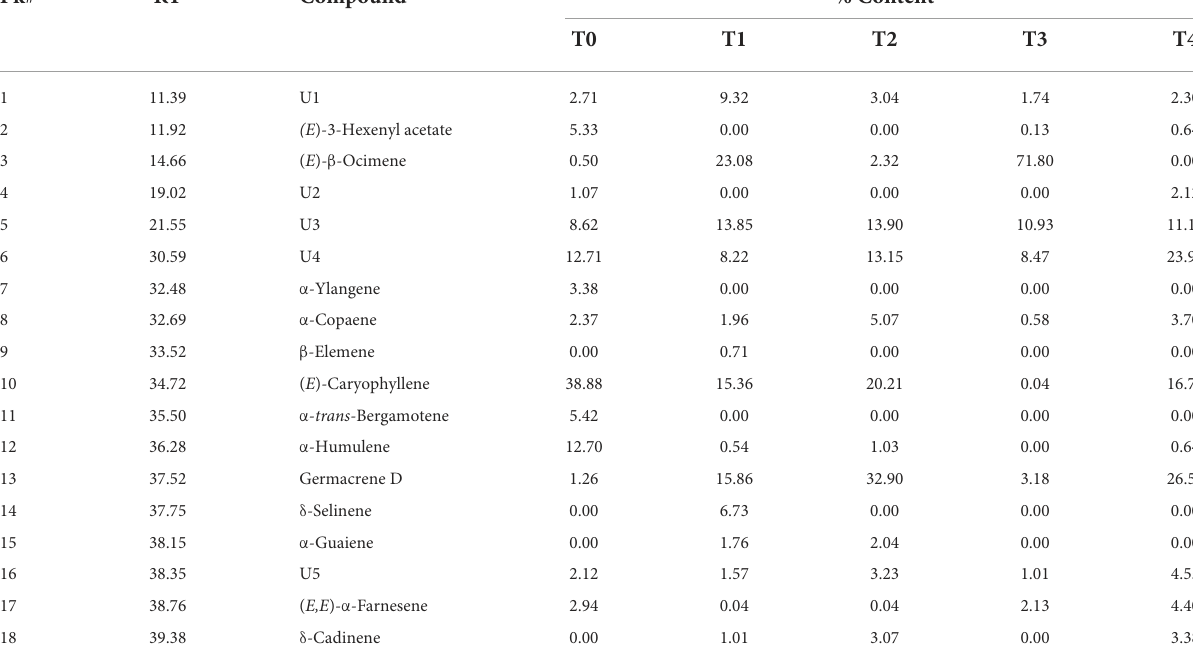
TABLE 6 Retention time (RT) and relative abundance (%) of the volatile compounds (identified and unknown) in the leaf extracts of drought stressed F. deltoidea plants treated and untreated with H 2 O 2 .